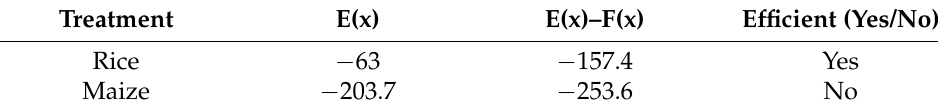
Figure 8. Stochastic dominance analysis ($/ha) of rice and maize production in the future. Table 4. Dominance analysis of rice and maize in 2020–2029 in northern Thailand.